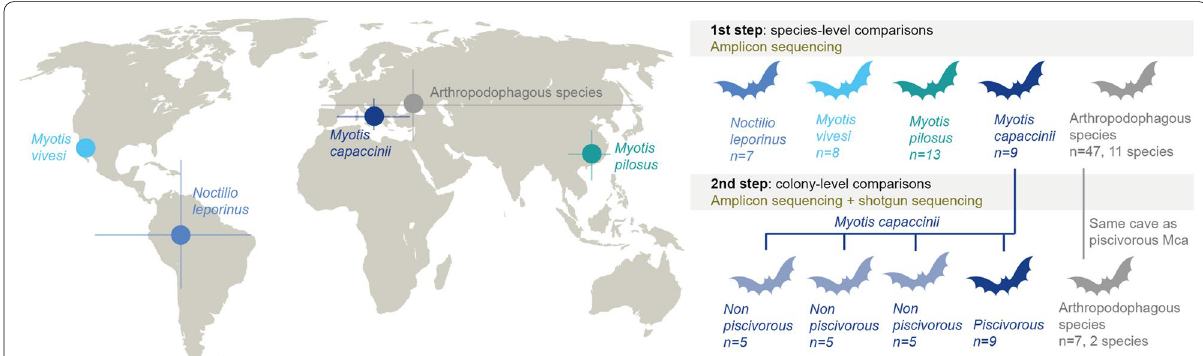
Fig. 1 Map of the approximate distributional range (latitude and longitude limits) of bats analysed in this study (left), and species and number of individuals (n) used in each step of the analysis (right). In the first step, 37 bats from four well‑known fish‑consuming colonies of the four piscivorous species were compared to 47 bats belonging to 11 strict arthropodophagous species. In the second step, we increased the resolution of the analyses in the piscivorous bat Myotis capaccinii , by adding more individuals (n 15) from three allegedly non‑piscivorous colonies to the analysis. = For these analyses we also included arthropodophagous bats that roost in the same cave as the piscivorous M. capaccinii, namely Miniopterus schreibersii and Myotis myotis as